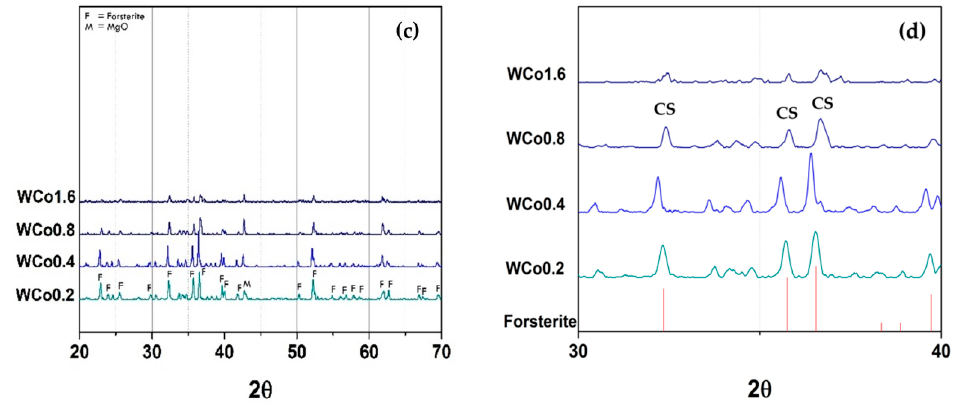
Figure 3. XRD patterns of Co x Mg (2 − x ) SiO 4 sample synthesized by mirror waste calcined at 1000 °C for 2 h: ( a , b ) x = 0–0.1; ( c , d ) x = 0.2–1.6.